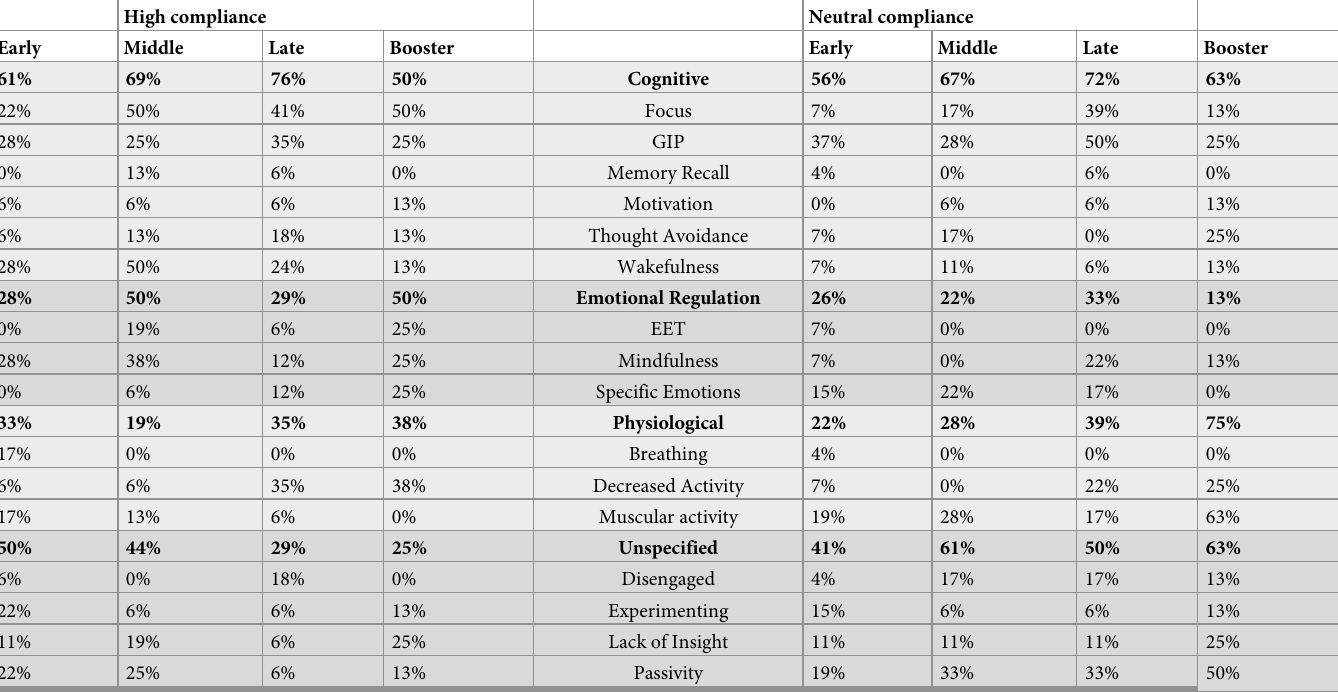
Table 6. Changes over time in strategies in high vs. neutral compliance—Frequency of strategies present in interviews per total